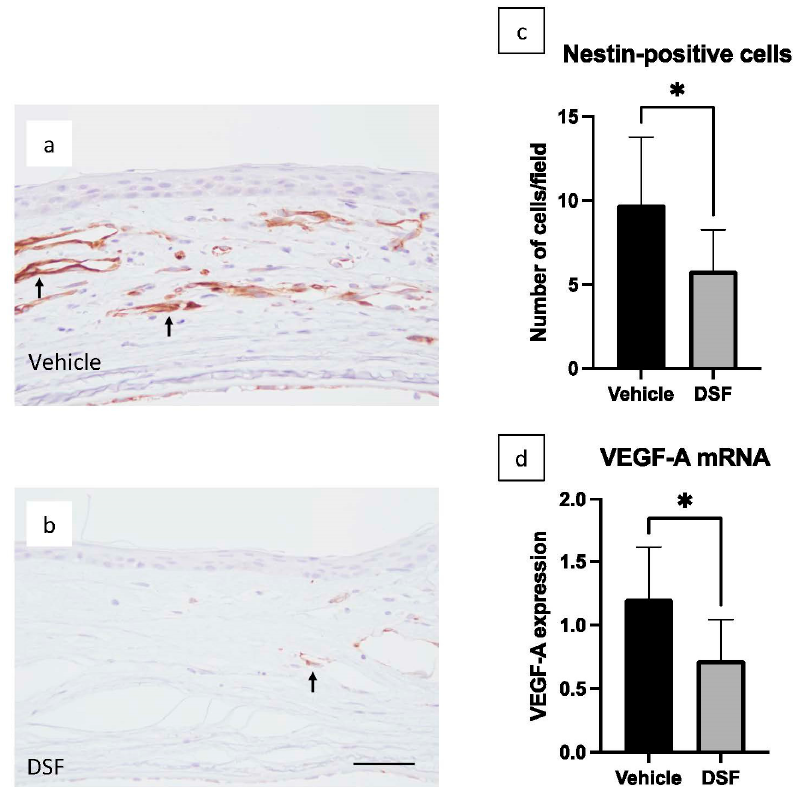
Figure 6. To evaluate neovascularization of the peripheral cornea, immunohistochemical analysis of nestin in the Vehicle group ( a ) and DSF group ( b ) was performed in rat corneas 4 days after alkali burn. Enumeration of nestin-positive vascular endothelial cells was performed and comparisons were made between the Vehicle and DSF groups ( c ). RT-PCR was performed in rat corneas 4 days after alkali burn to examine VEGF-A expression and comparisons were made between the Vehicle and DSF groups ( d ). Bar, 50 µ m. The black arrows indicate nestin-positive cells. Data are shown as mean ± standard error ( n = 8 samples/group). * p < 0.05.